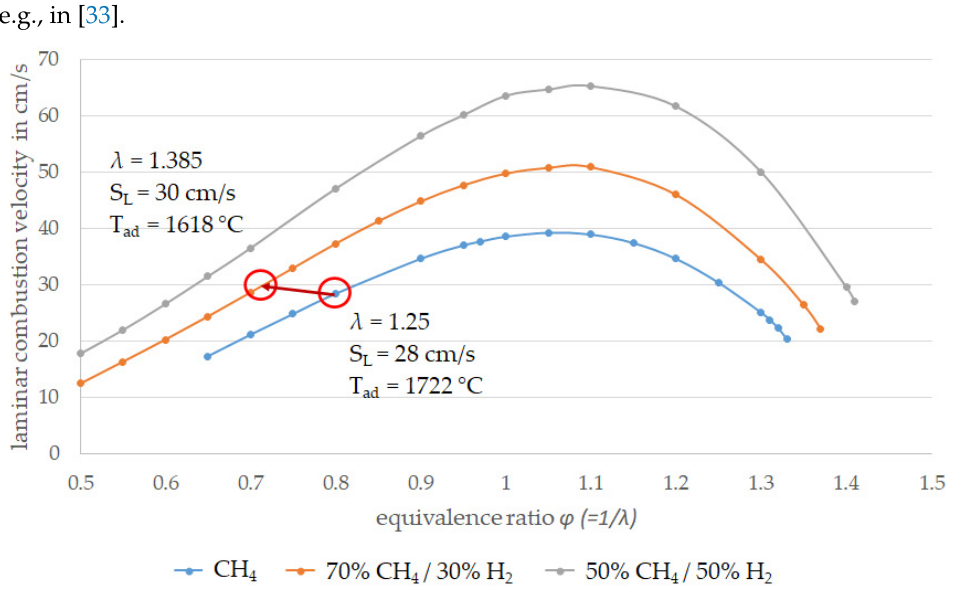
Figure 6. Effects of 30 vol.% H 2 admixture on laminar combustion velocity and adiabatic combustion temperature for an appliance with combustion control. Nevertheless, the control system has at least some effect. For example, in a completely uncontrolled system, a hydrogen concentration of 40 vol.% should have shifted the air